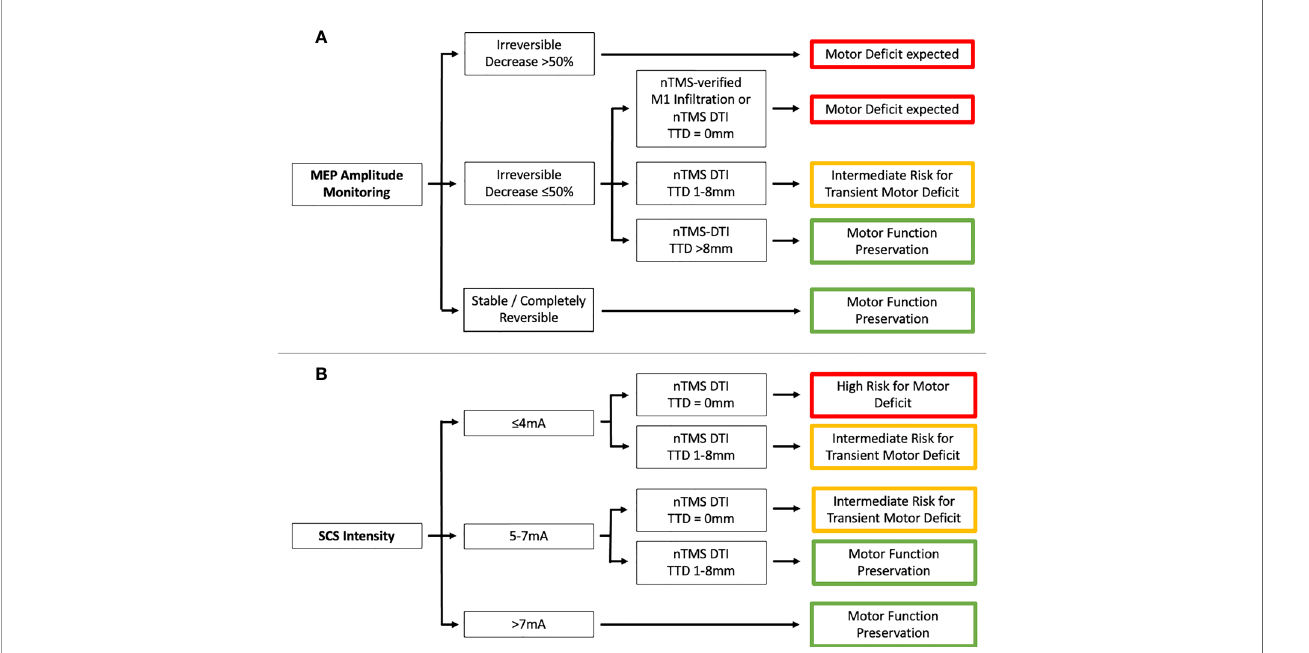
FIGURE 4 | Flowchart showing the association between preoperative nTMS assessment (motor cortex [M1] in fi ltration and tumor-tract distance [TTD]) and IOM ( A - MEP amplitude monitoring and B - SCS